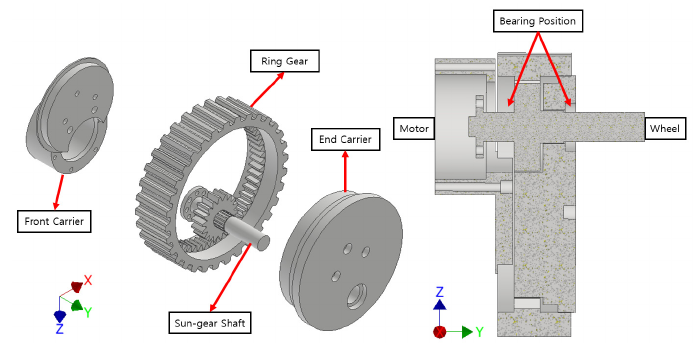
Figure 3. Exploded and cross-sectional view of the dual-speed transmission system .